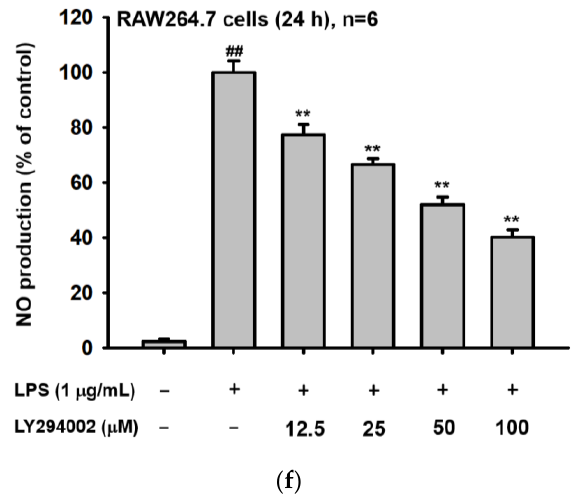
Figure 3. Ho-ME affected intracellular signaling by targeting AKT. ( a ) Western blot image of inflam- matory response-related proteins. ( b , c ) The protein target of Ho-ME was reaffirmed in AKT1- and AKT2-overexpressing HEK293T cells. p-IKK α / β was determined by immunoblotting analysis. The relative band intensity level of p-IKK α / β was calculated with ImageJ software. ( d ) Ho-ME enhanced the thermostability of AKT2 by binding. ( e ) The Ho-ME binding domain was elucidated with do- main-truncated AKT2 overexpression. ( f ) LY294002, a PI3K inhibitor, eliminated NO production in RAW264.7 cells. All data are presented as mean ± standard deviation (SD) calculated from the indi- cated number of independent samples. The numbers above each image in ( a , b ) and ( d , e ) are relative intensity values, measured using ImageJ software. L.E.: Long exposure. S.E.: Short exposure. ##: p < 0.01 compared to the non-stimulated group, *: p < 0.05 and **: p < 0.01 compared to the control or AKT1 overexpression group, and $$: p < 0.01 compared to AKT2 overexpression group.